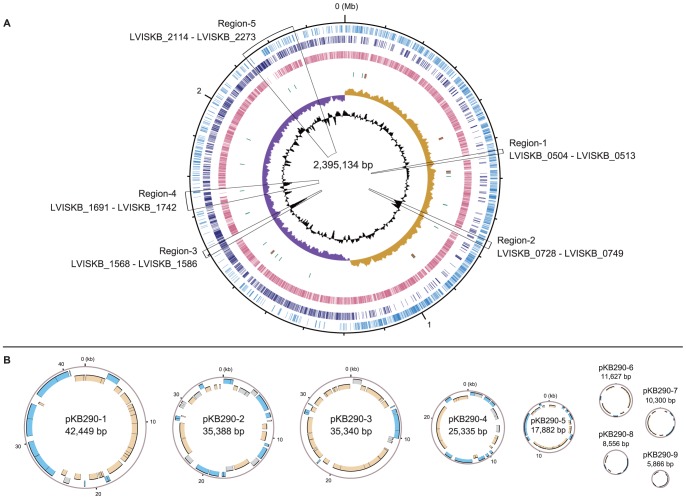
Circular representation of the KB290 chromosome (A) and nine plasmids (B).(A) From the outside in: Circles 1 and 2 of the chromosome show the positions of protein-coding genes on the positive and negative strands, respectively. Circle 3 shows the positions of protein-coding genes that have orthologs in L. brevis ATCC 367. Circle 4 shows the positions of tRNA genes (green) and rRNA genes (brown). Circle 5 shows a plot of GC skew [(G − C)/(G + C); khaki indicates values >0; purple indicates values <0]. Circle 6 shows a plot of G + C content (higher values outward). (B) The outer and inner circles of each plasmid represent genes on the positive and negative strands, respectively. The transposase genes are shown in gray.